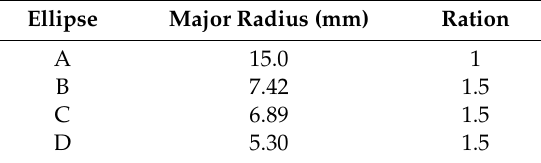
Table 2. Ring Table 2. Ring specifications.